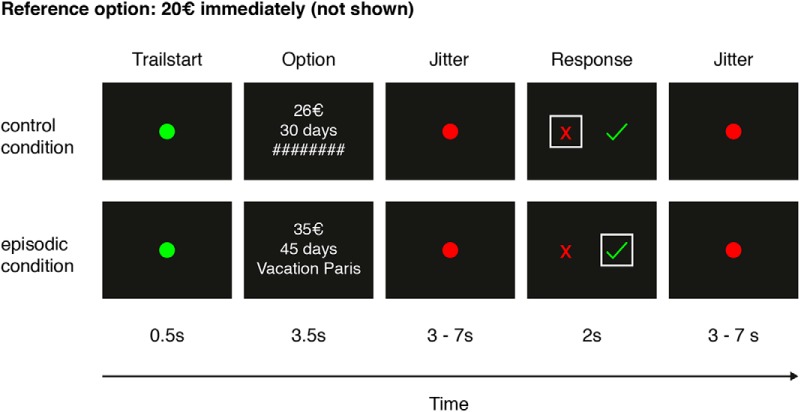

Illustration of one example trial from the control condition (top) and the episodic condition (bottom). Participants made choices between a reference option of 20 euros immediately and LL options. Offers in the control condition consisted of amount and delay, whereas offers in the episodic condition where enriched using participant-specific real future event tags (see Materials and Methods). Selecting check is to accept the LL offer, selecting X is to choose 20 euros immediately. Trials were presented in pseudo-randomized order.